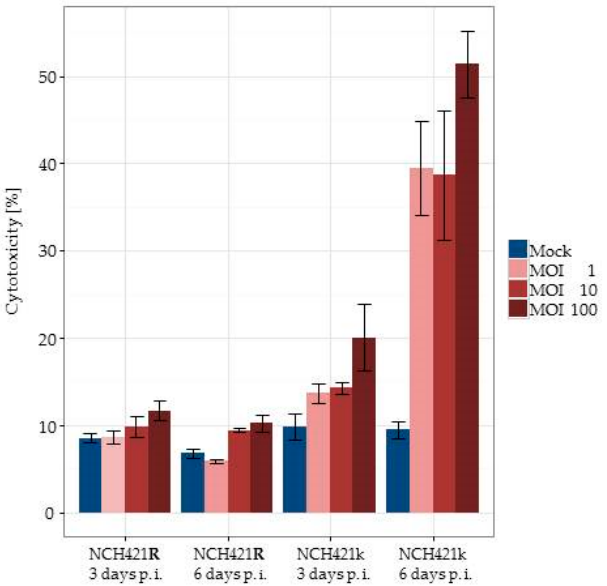
Figure 6. H ‐ 1PV infection induces lytic infection of HGG neurospheres in vitro . Lactate dehydrogenase (LDH) ‐ release assays were performed on NCH421k and NCH421R cells at days 3 and